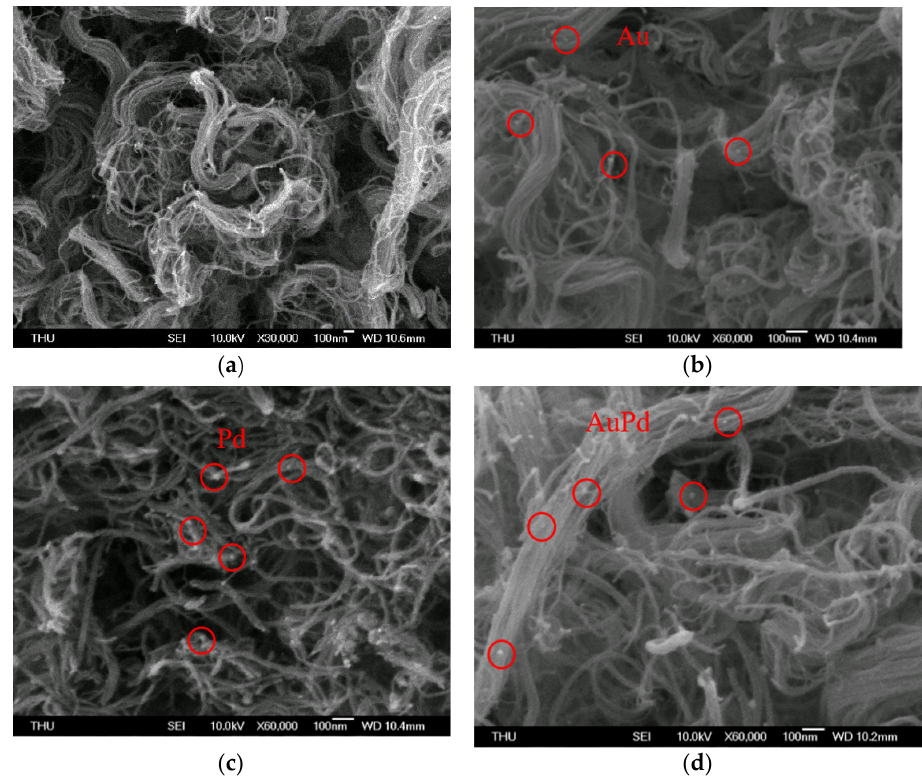
Figure 3. SEM images of ( a ) MWCNT, ( b ) 1% Au/MWCNT, ( c ) 1% Pd/MWCNT, ( d ) 1% Pd-5% Au/MWCNT.